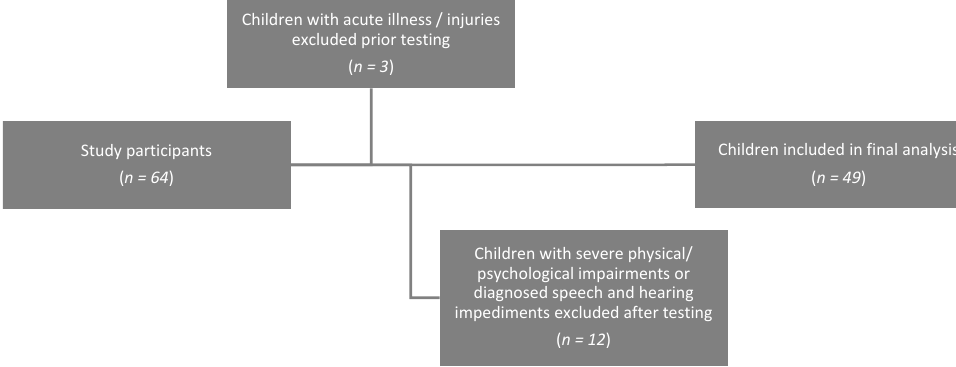
Figure 1. Selection of study participants.